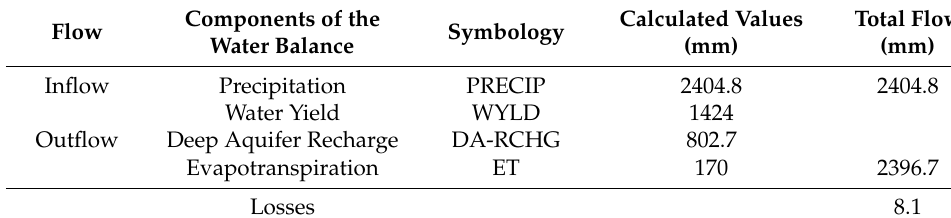
Table 4. SWAT model calibration results.